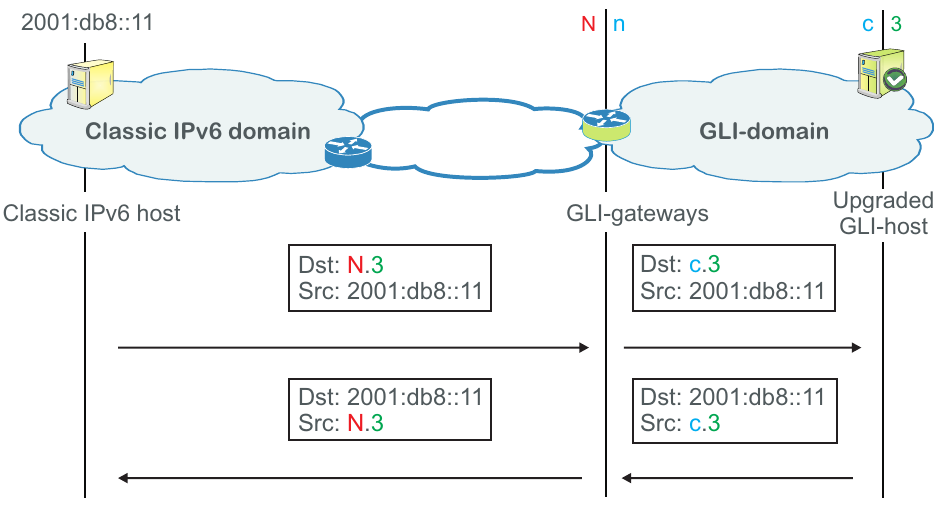
Figure 5. IPv6 node with IP address 2001:db8::11 in a non-GLI domain communicates with GLI-node 3 in